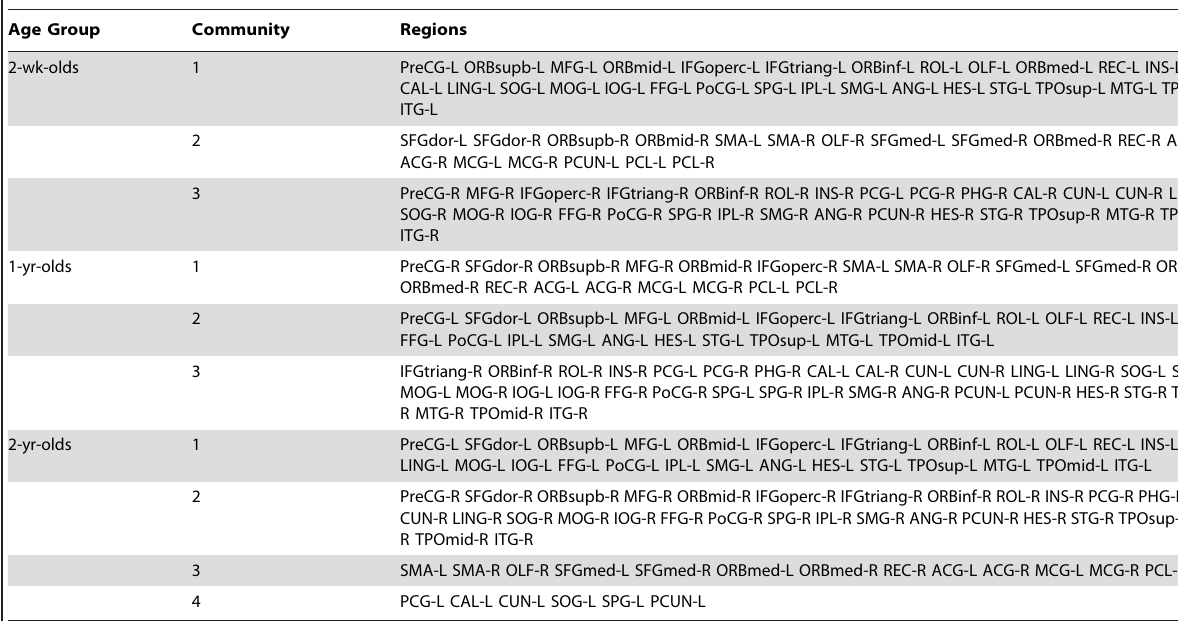
Table 3. Constituent Regions in Each Community.